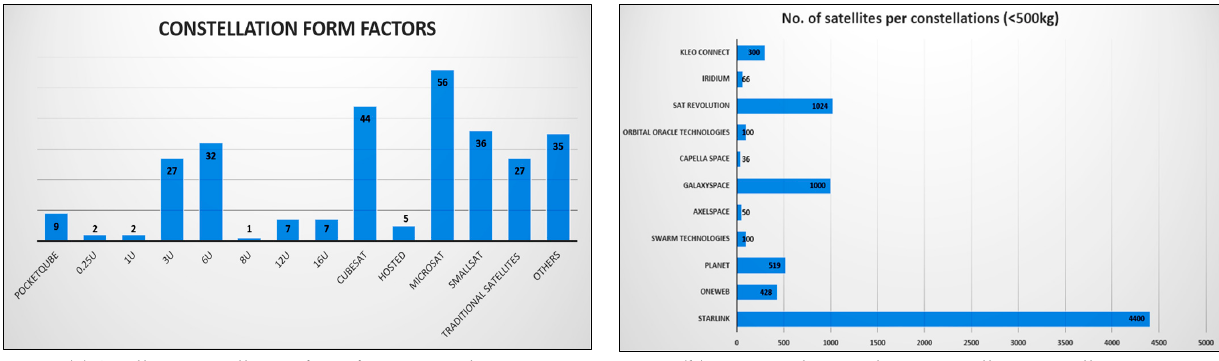
Figure 2. Satellite constellation statistics in recent years.